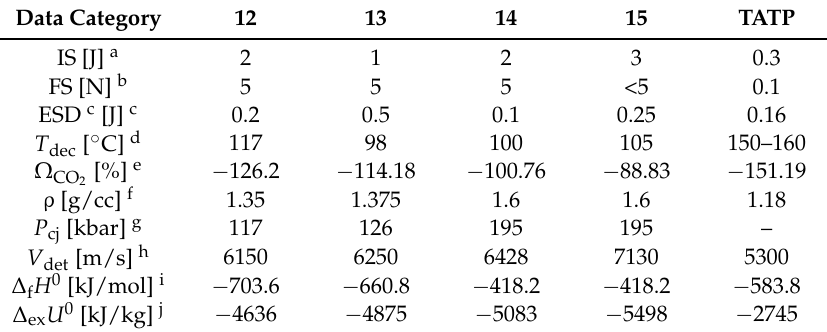
Table 1. Sensitivities and performance of geminal peroxides 12–15 and TATP.